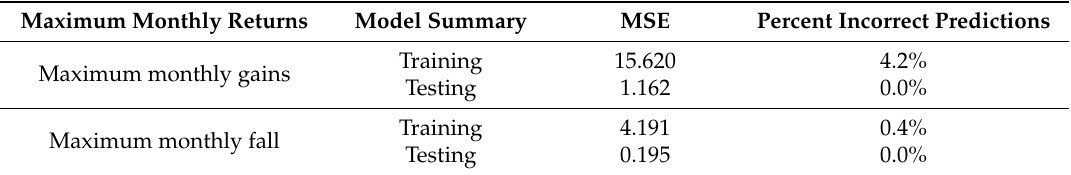
Table 5. Network performance for GSE maximum monthly.